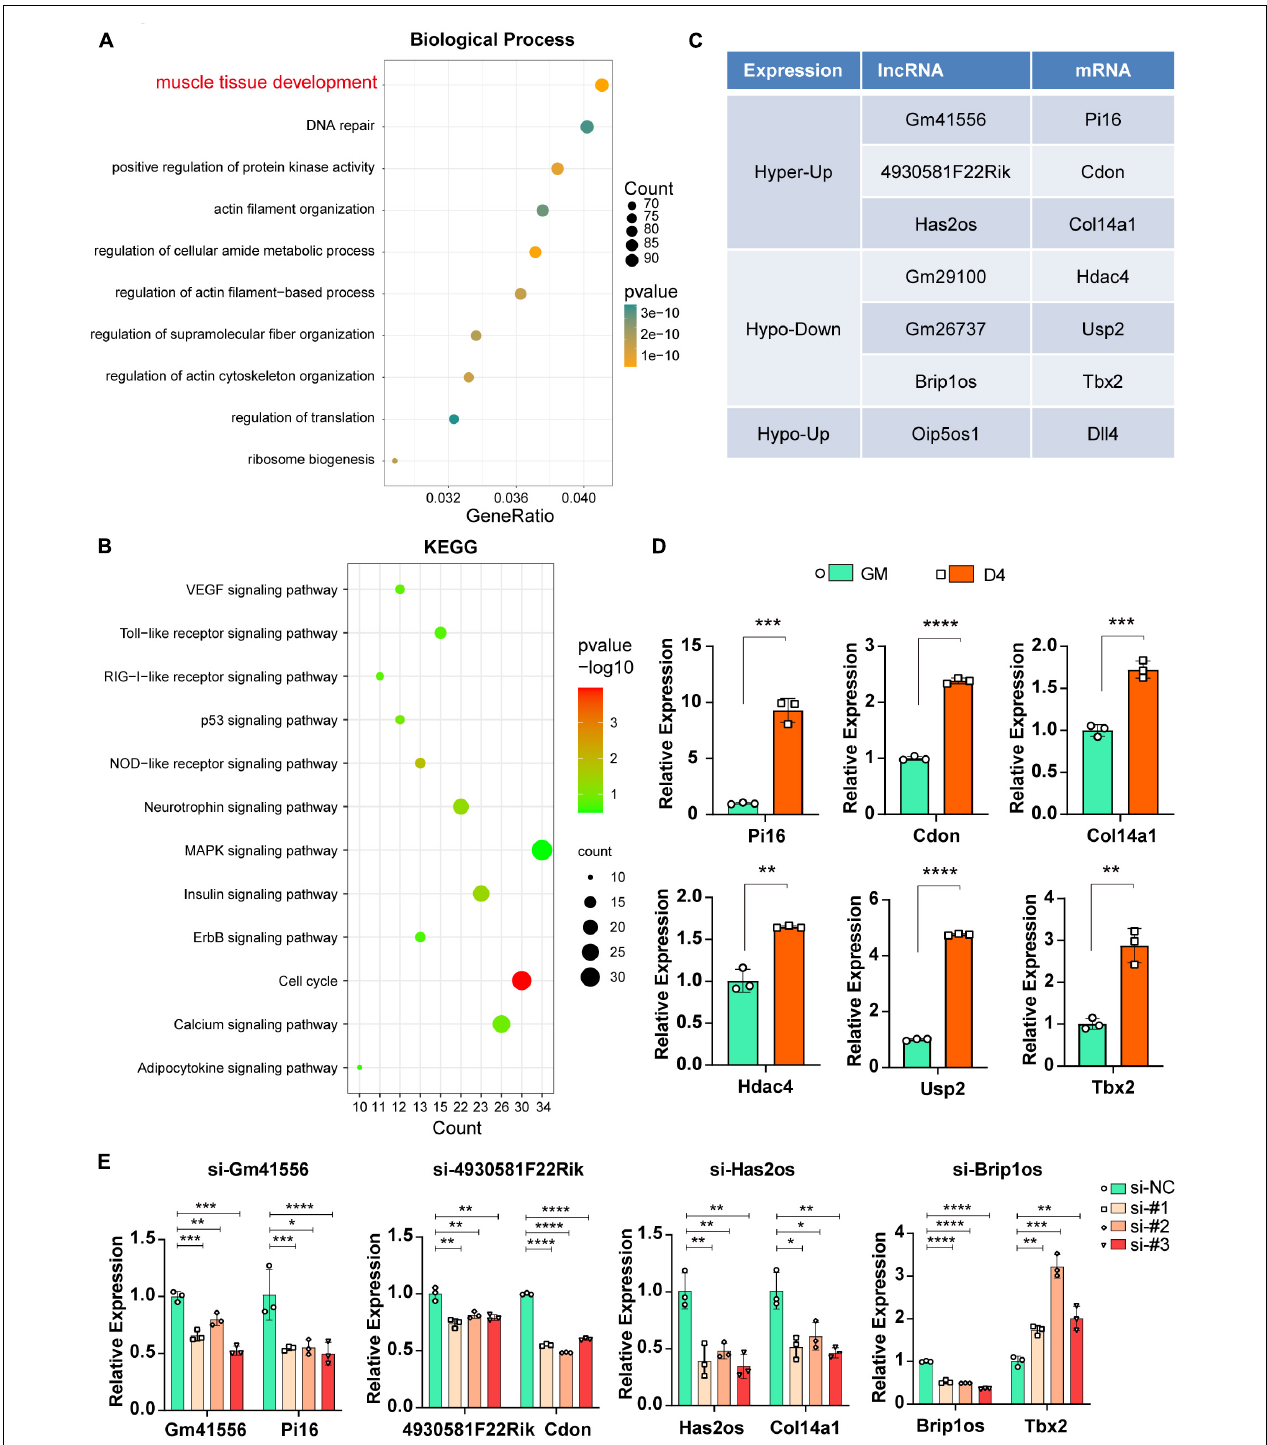
FIGURE 6 | Functional relevance between m 6 A methylated lncRNAs and their adjacent mRNAs. (A) The top ten GO terms of the adjacent mRNAs (adjusted P ≤ 0.05) that related to differentially expressed lncRNAs in muscle cells. (B) The top twelve KEGG pathways of the adjacent mRNAs (adjusted P ≤ 0.05) that related to differentially expressed lncRNAs in muscle cells. (C) Table shows seven pairs of significantly differently expressed and methylated lncRNAs and their adjacent mRNAs in muscle cells. All have a significant threshold of FDR-adjusted p value ≤ 0.05. FDR, False Discovery Rate. (D) qRT-PCR shows the adjacent mRNA expression in GM and D4. (E) The effects of si-lncRNAs on the RNA expression levels of the corresponding lncRNA and mRNA. Data are presented as Mean ± SD; p value: * p < 0.05, ** p < 0.01, *** p < 0.001, **** p < 0.0001.